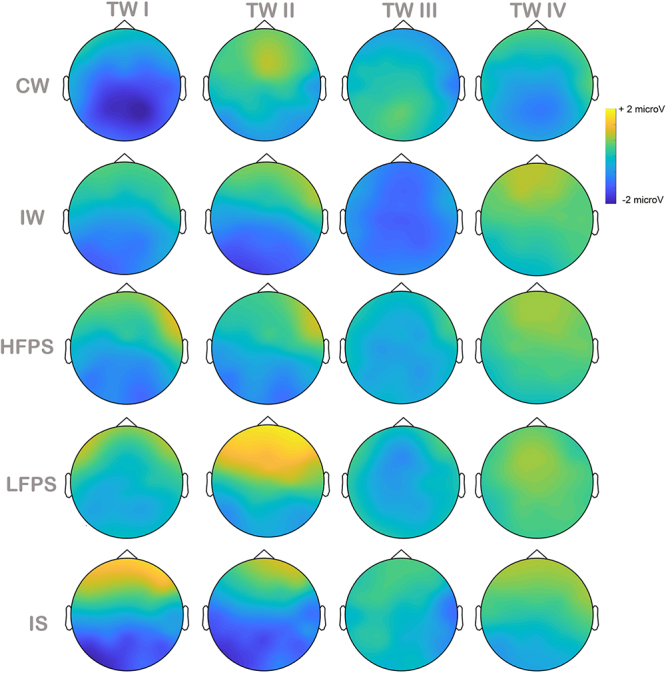
Topographic maps per time window and condition: CW (Congruent Word), IW (Incongruent Word), HFPS (High-Frequency Pseudoword), LFPS (Low-Frequency Pseudoword), IS (Illegal Sequence); TW I (140–250 ms), TW II (330–450 ms), TW III (600–650 ms), TW IV (870–1000 ms).